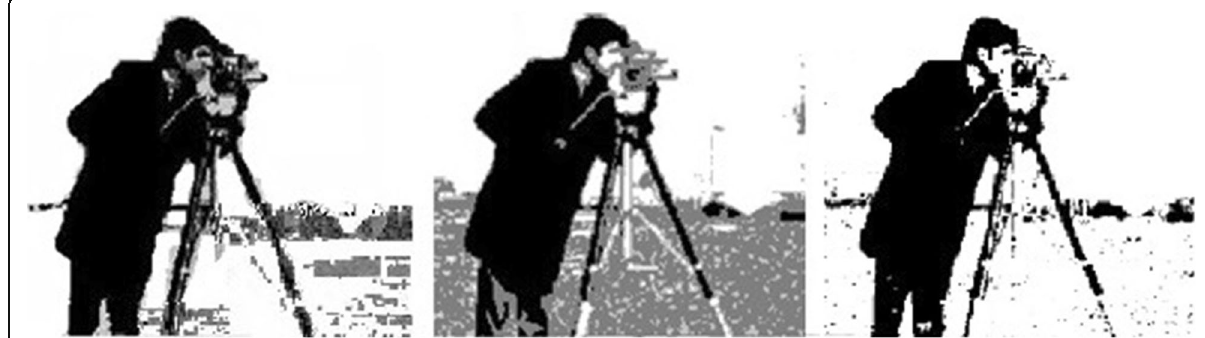
Fig. 2 Segmentation results on Photographer images with resolutions (the left is the 64×64 image, the middle is the 128×128 image, and the right is the 256×256 image)